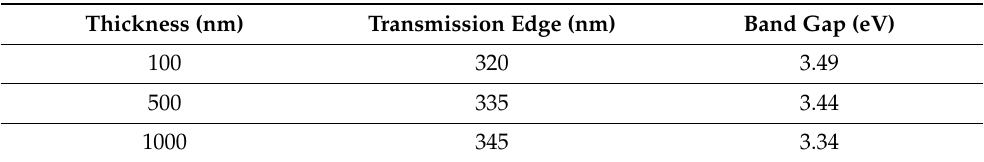
Table 2. Transmission edge and band-gap energy of the TiO 2 films with 100 nm, 500 nm, and 1000 nm film